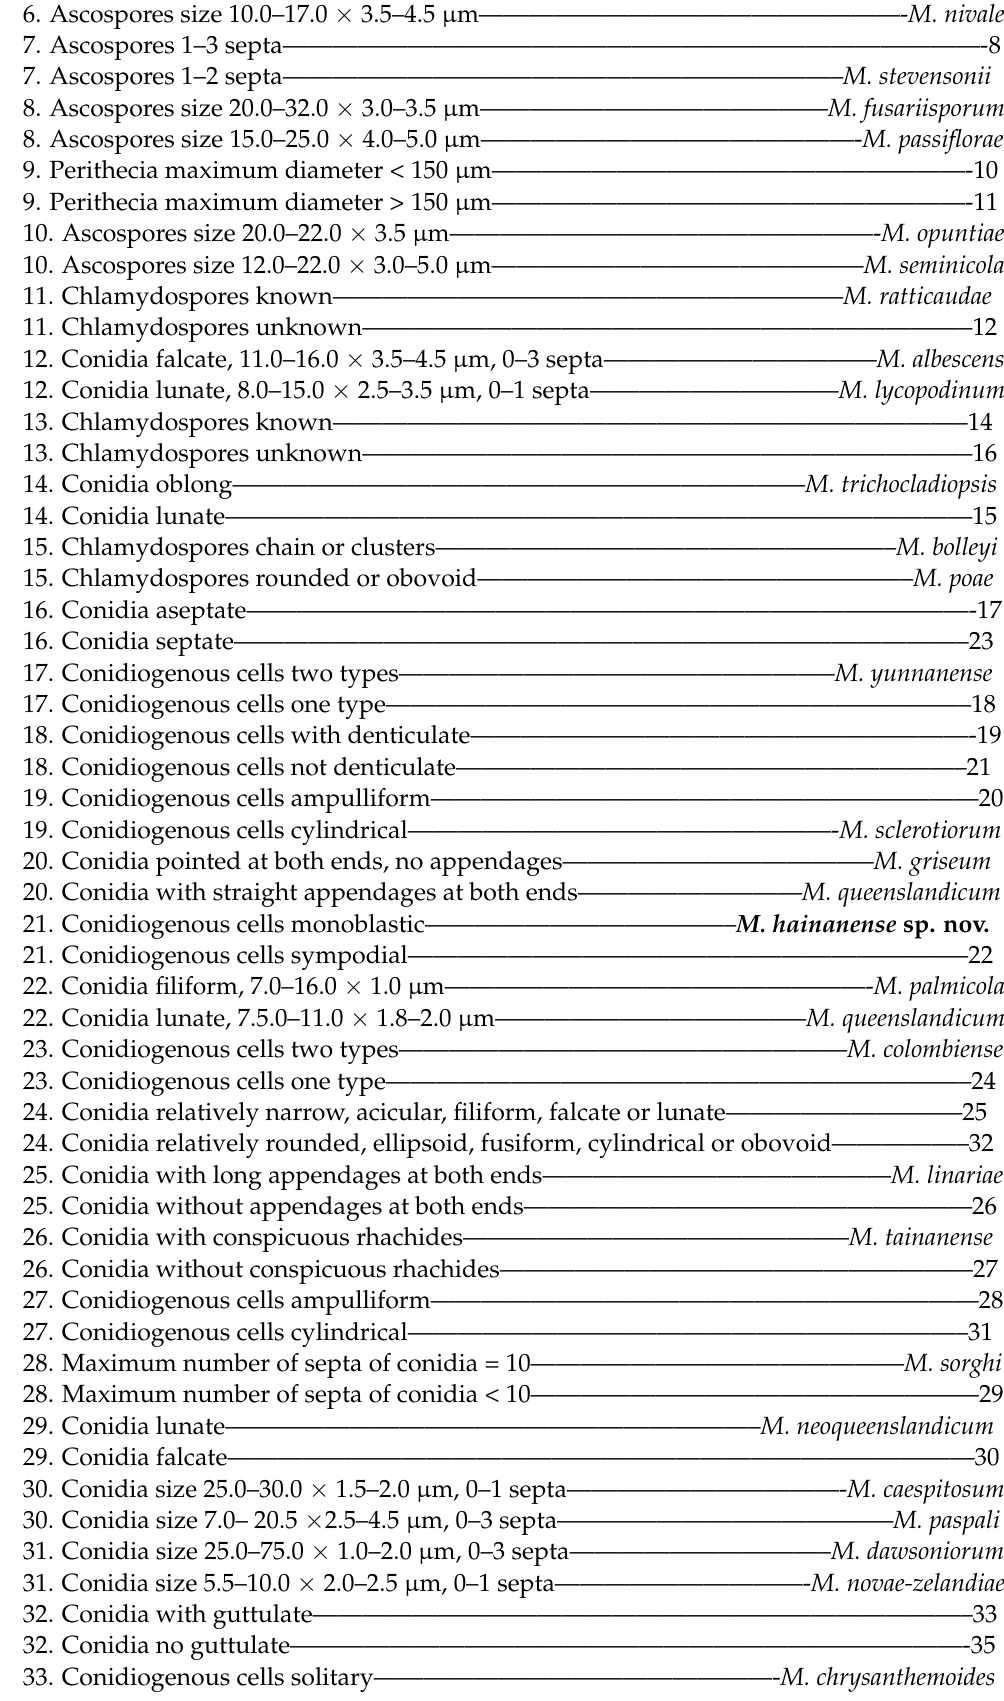
32. Conidia with guttulate——————————————————————————–33 32. Conidia no guttulate———————————————————————————-35 33. Conidiogenous cells solitary————————————————- M.